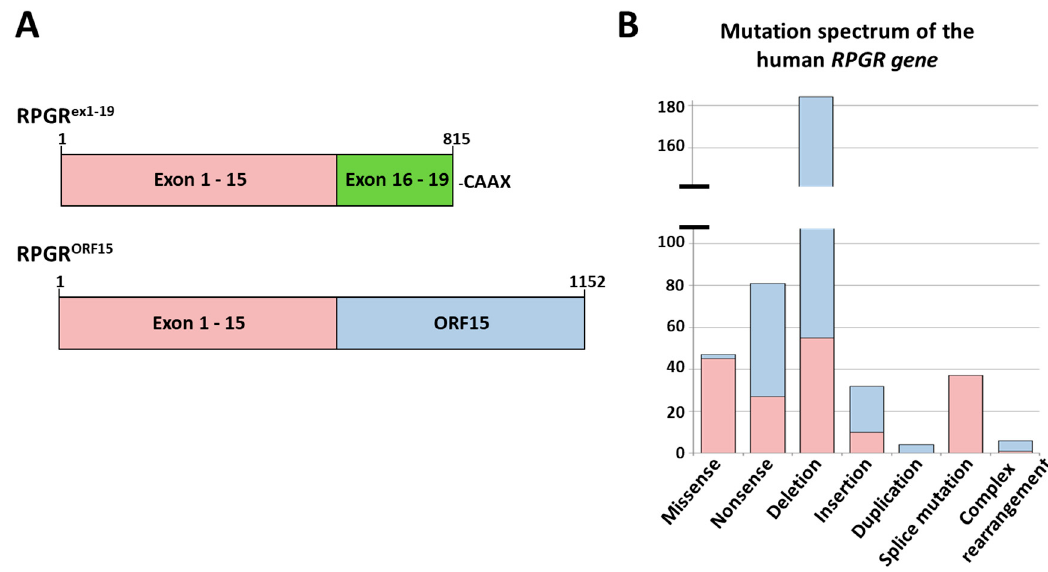
Figure 1. RPGR isoforms RPGR ex1–19 and RPGR ORF15 and the distribution of reported disease-causing RPGR mutations. ( A ) The transcript RPGR ex1–19 is widely expressed, consists of exon 1 to 19 (exon 1–15 (red); exon 16–19 (green)) and encodes for a 815 amino acid protein containing an isoprenylation site (CAAX) at the C-terminus. Of note, the widely expressed isoform RPGR skip14 / 15 , which skips exons 14 and 15 during splicing, is not shown. The retina-specific isoform RPGR ORF15 includes exon 1 to 15 (red) and the exon ORF15, a highly repetitive purine rich domain (blue). ( B ) Reported RPGR mutations include 391 disease-causing sequence alterations. Deletions were most frequently identified, followed by nonsense mutations and missense mutations. Disease-causing mutations were not reported for exons 16 to 19.